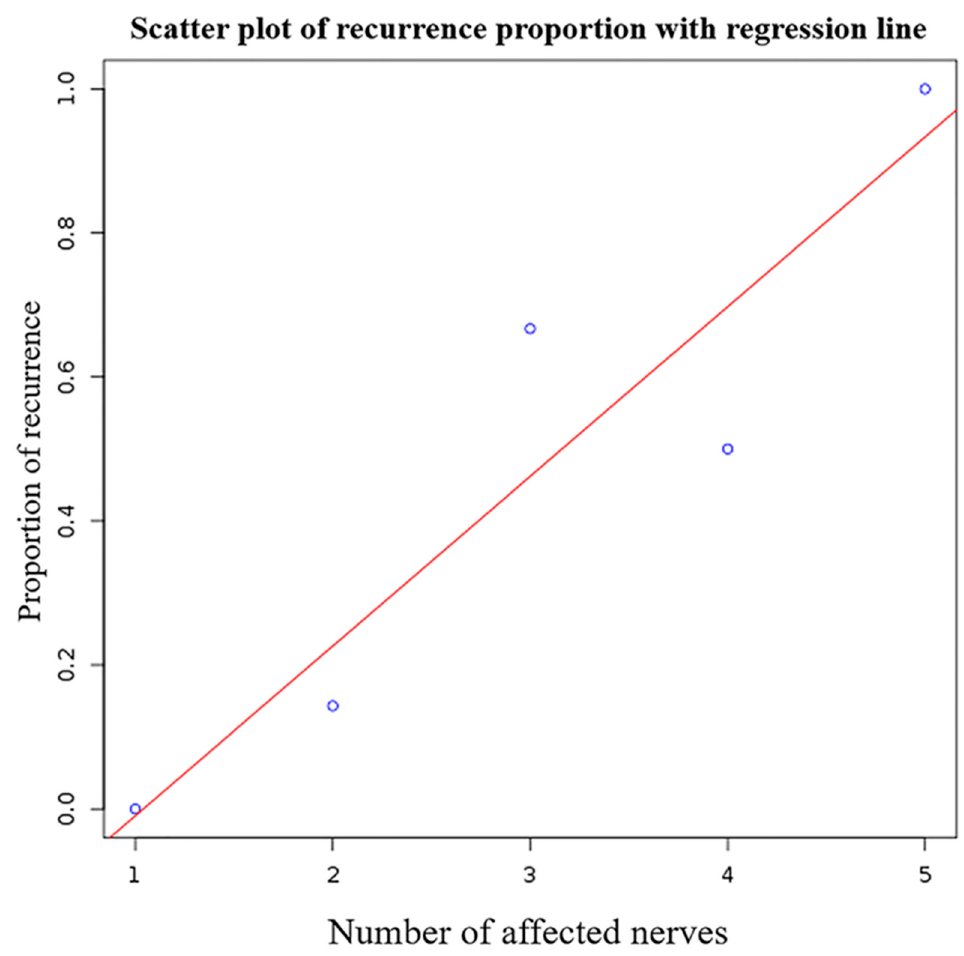
Figure 3. Scatter plot of recurrence proportion by number of affected nerves with regression line .